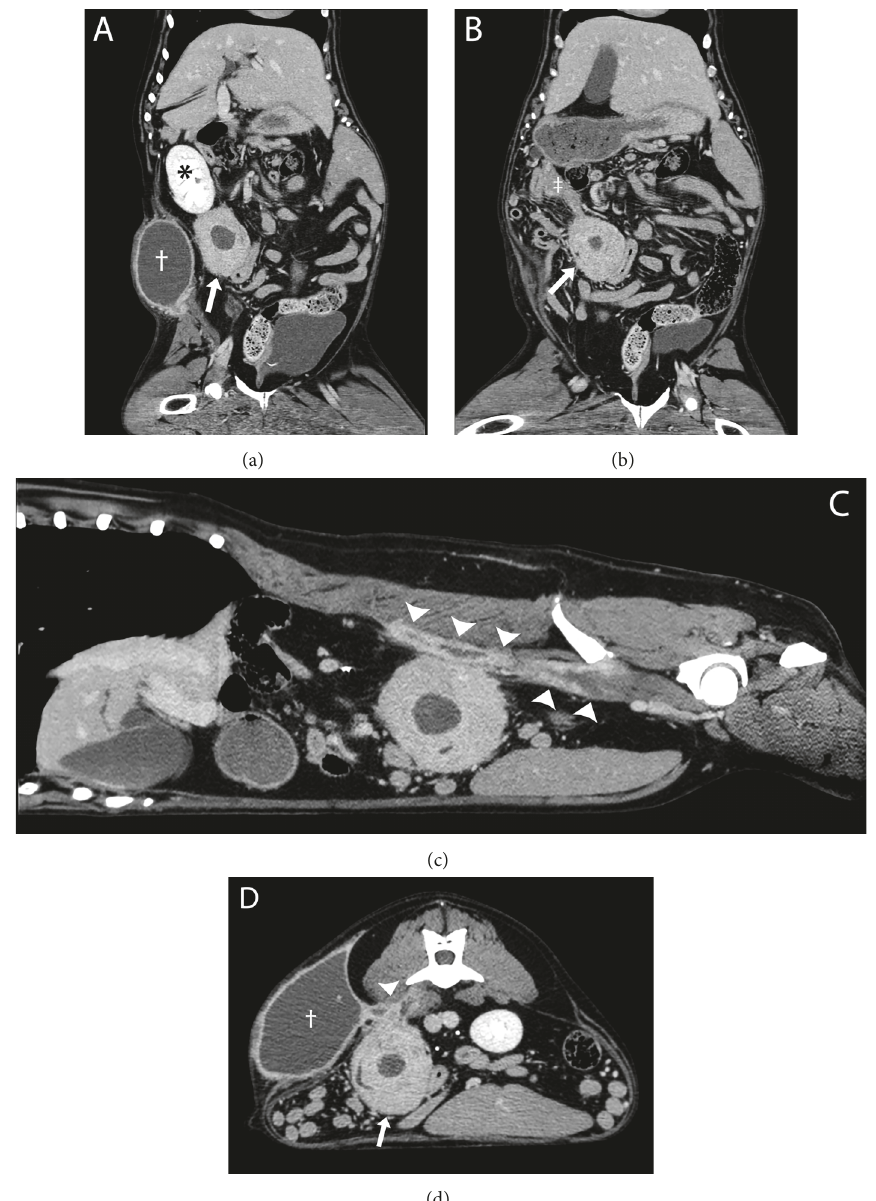
Figure 3: Postcontrast computed tomographic images of the abdomen on the patient’s initial presentation, displayed in soft tissue window. (a) Dorsal oblique multiplanar reconstruction displaying a large, heterogeneously contrast-enhancing, cavitary, non-organ associated abdominal mass (white arrow), caudal to the right kidney ( ∗ ). A large, rim enhancing, cystic subcutaneous mass ( † ) is also noted in the right lumbar subcutaneous tissues, resulting in focal medial displacement of the abdominal wall. (b) Dorsal multiplanar reconstruction displaying the association between the abdominal mass (white arrow) and the right limb of the pancreas ( ‡ ). (c) Sagittal multiplanar reconstruction displaying the rim enhancing fistulous tracts (arrowheads) extending in a cranial to caudal fashion in the right hypaxial musculature. (d) Transverse image displaying the rim enhancing fistulous tracts (arrowhead) interconnecting the abdominal mass (white arrow), cystic subcutaneous mass ( † ), and hypaxial